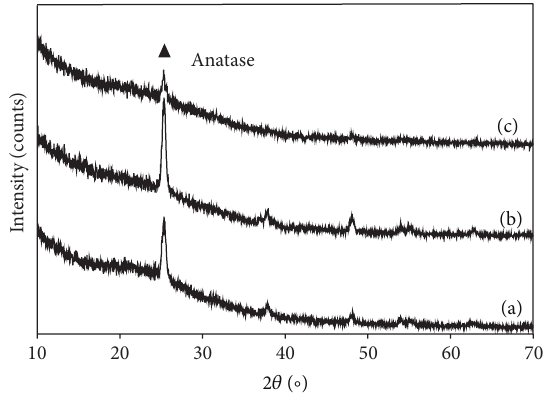
Figure 2: EDS spectra for (a) uncoated glass, (b) TiO 2 , (c) 3SnO 2 /TiO 2 coating, and (d) 20N/3SnO 2 /TiO 2 coating, all calcined at 600 ∘